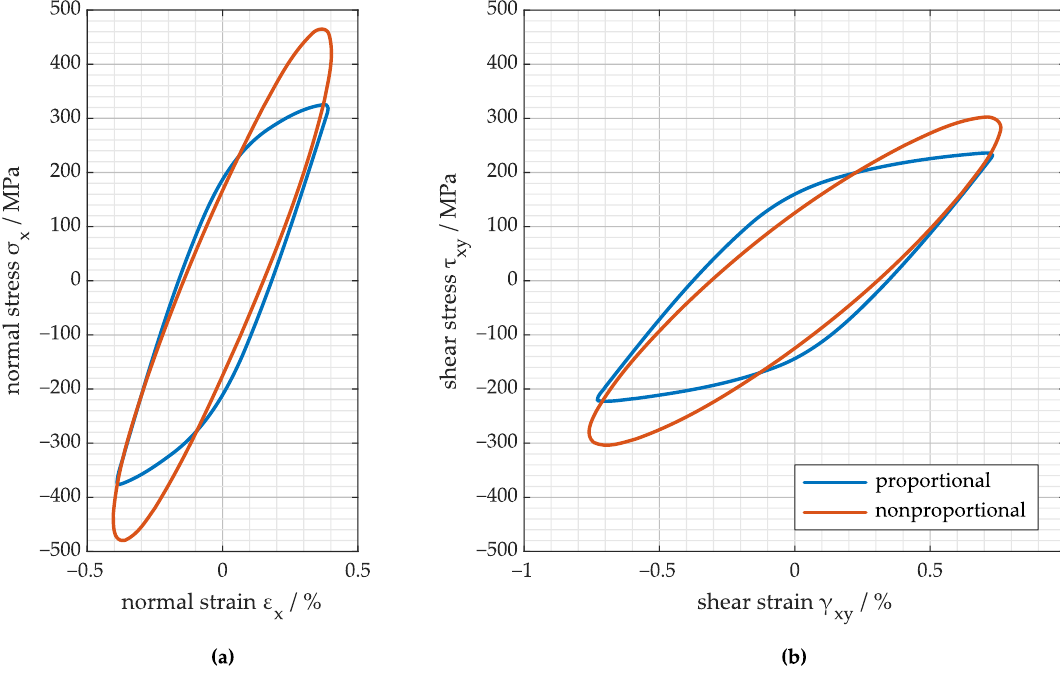
Figure 14. Stress–strain hysteresis for proportional loading and nonproportional loading with phase shift of 90° at the same normal and shear strain amplitudes: ( a ) normal stresses and strains and ( b ) shear stresses and strains.